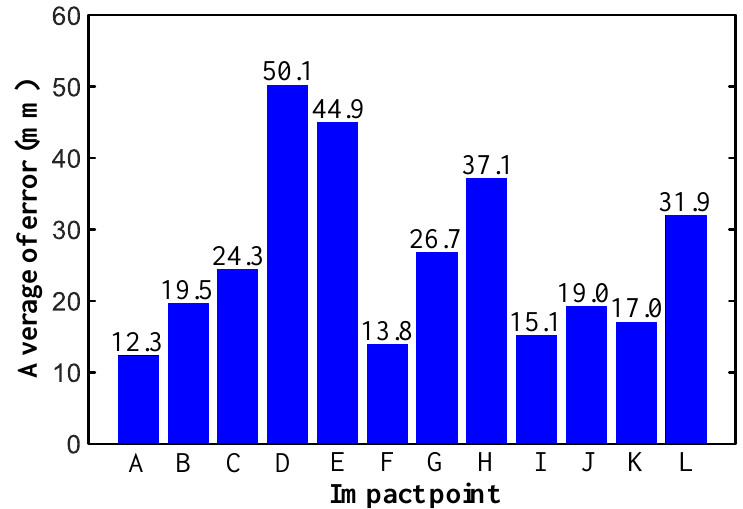
Figure 11. The mean absolute error at the impact points.